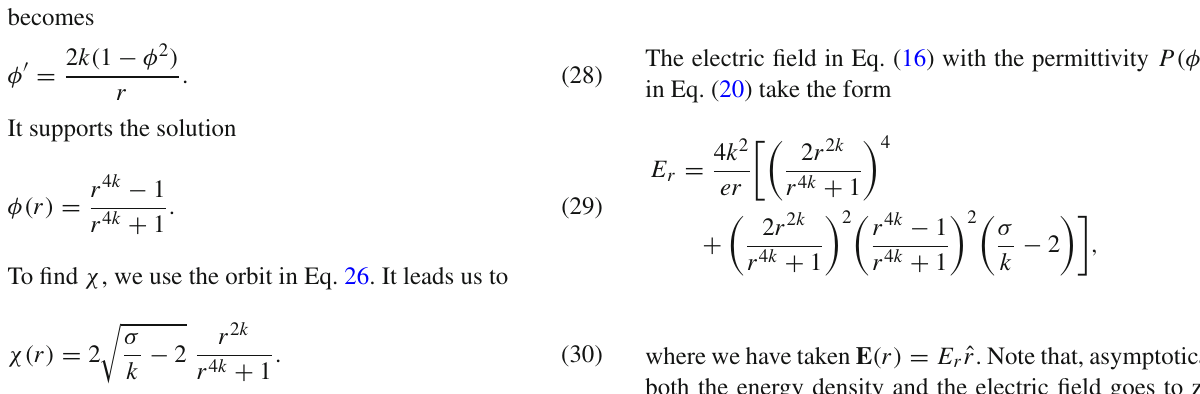
Fig. 1 The solutions φ( r ) (top) and χ( r ) (bottom) associated to the model in Sect. 3.1 for σ = 5, with k = 1 (solid, blue line) and 2 (dotted, red